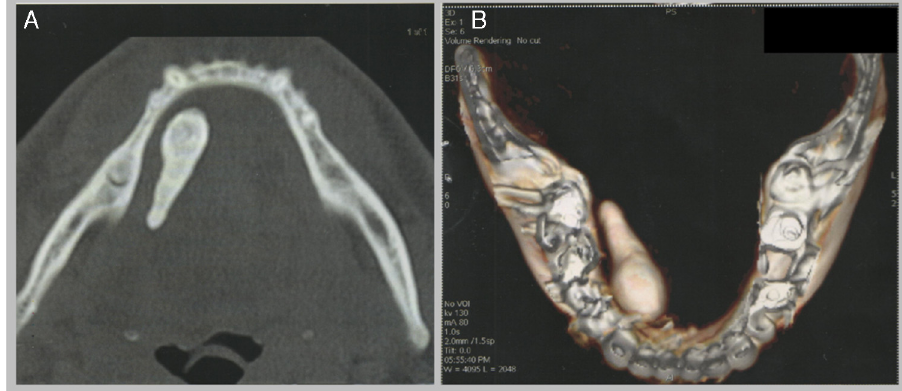
Figure 1 (A) Computed tomography scan (axial aspect) revealing a mineralized tissue with heterogeneous density and dimensions of 3.0 × 1.0 cm, approximately. (B) Three-dimensional image of the sialolith and the mandible. Since the sialolith had exuberant dimensions, an excision duct was proposed. Blood tests and surgical risk exams were requested for the patient.